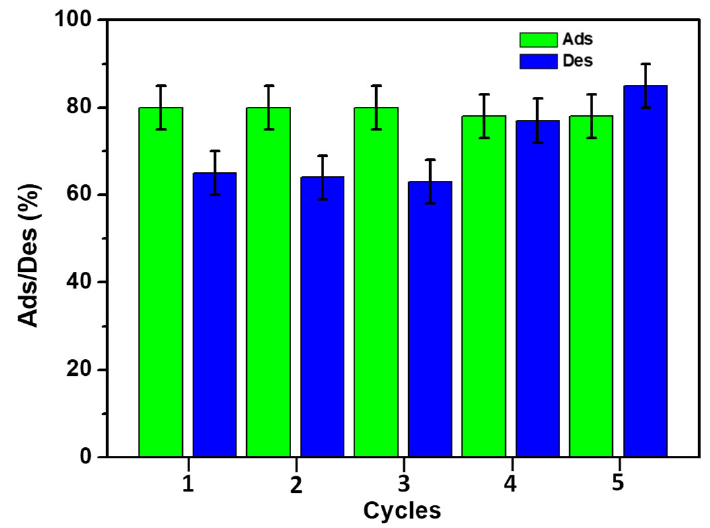
Figure 7. Consecutive CBZ adsorption–desorption cycles performed on 375 mg of β -EPI. For each cycle, 15 mL of 5 mg/L CBZ aqueous solutions and 15 mL of methanol were used.